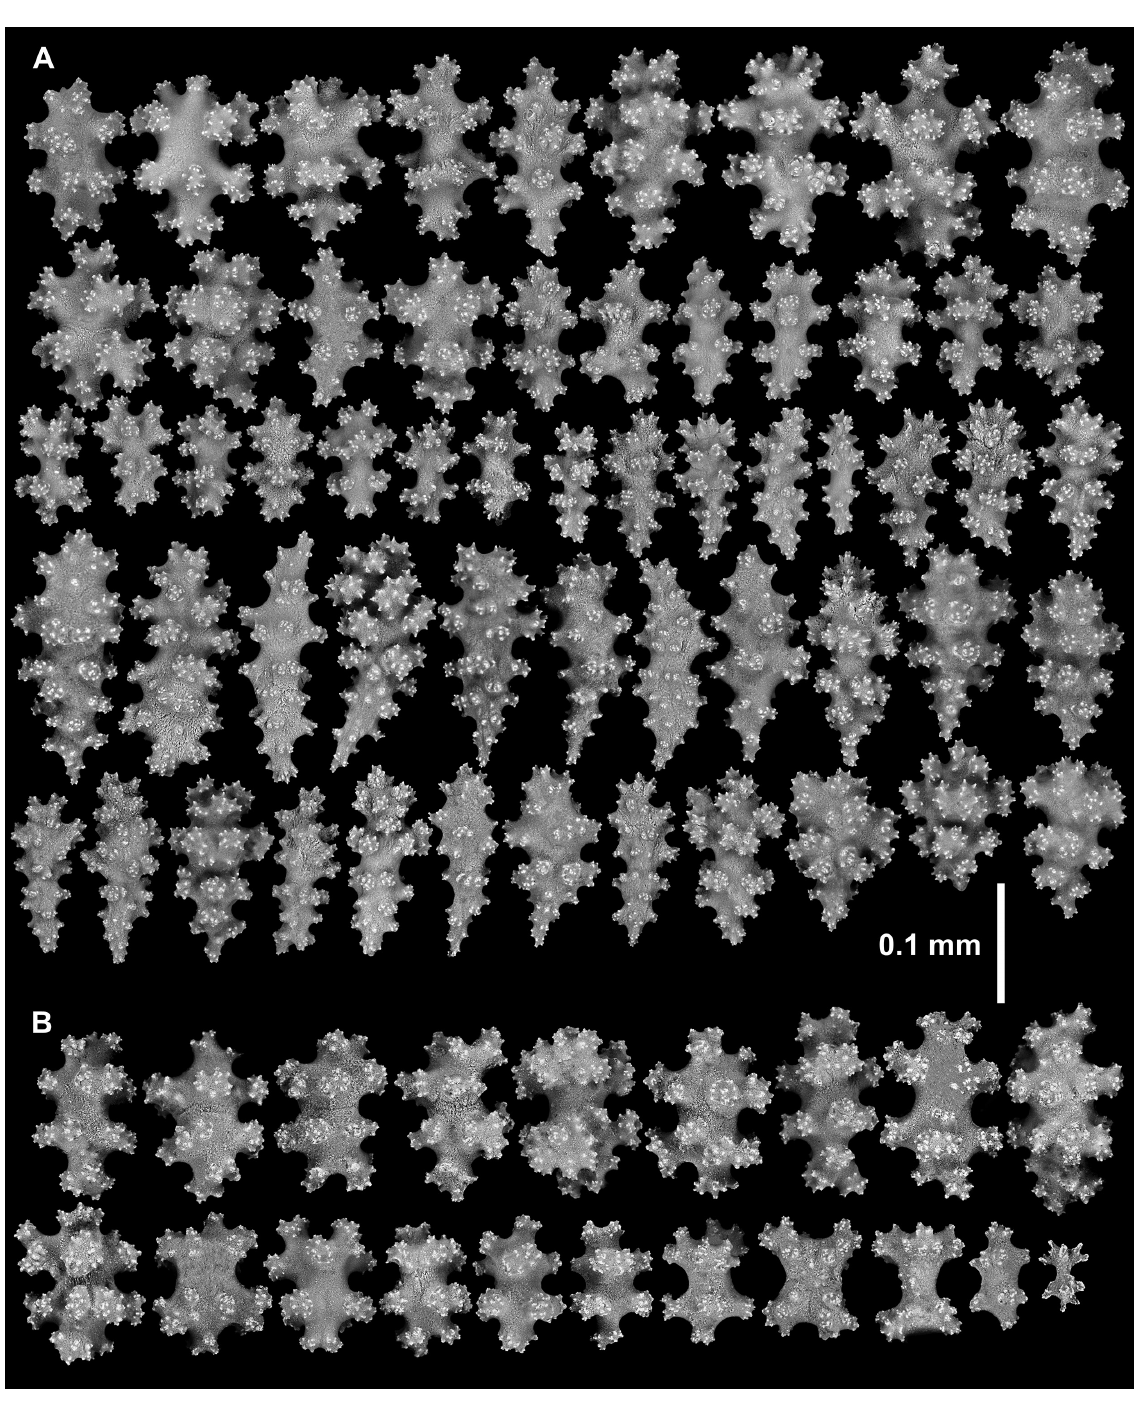
Fig. 30. Ushanaia ferruginea gen. et sp. nov., holotype (NIWA 156313), SEMs of sclerites. A . Surface (of thick, fleshy areas of colony). B . Interior (of thick, fleshy areas of